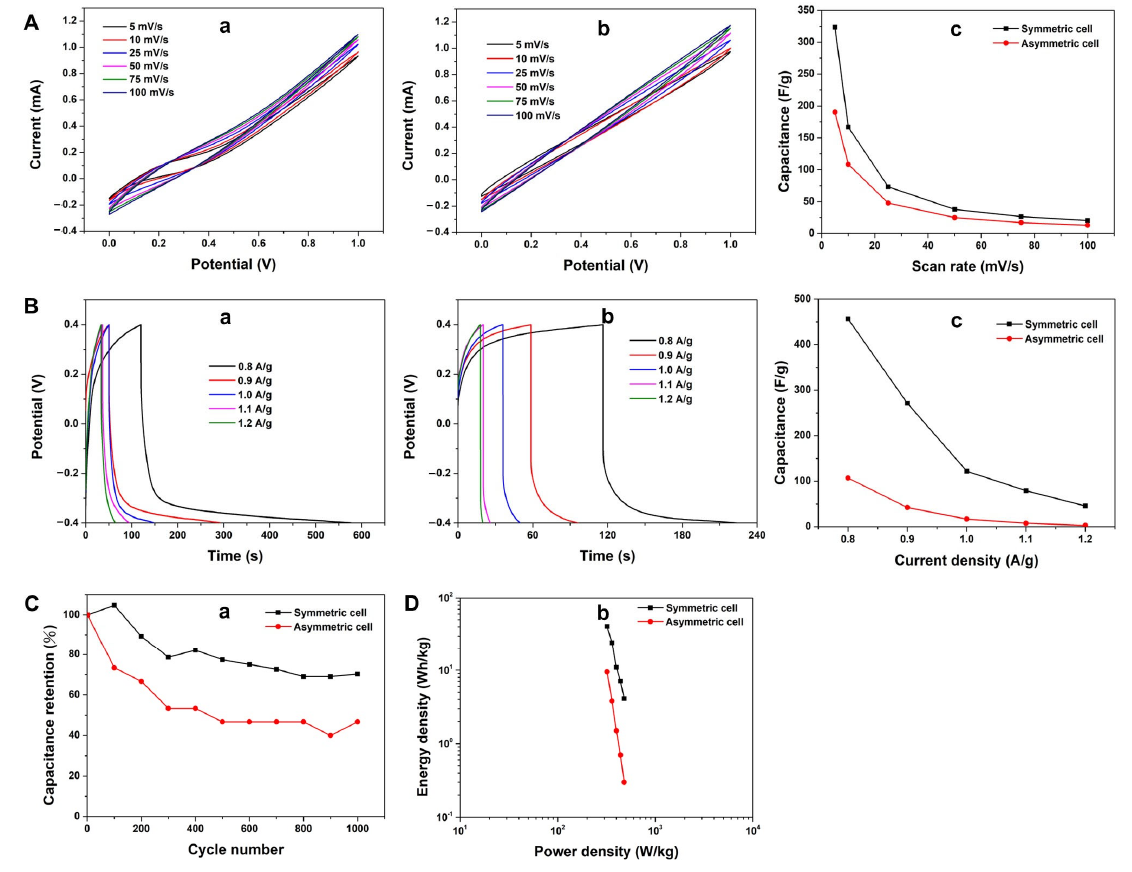
Figure 8. ( A ) CV and ( B ) GCD curves of ( a ) symmetric ( A ) CV and ( B ) GCD curves of ( a ) symmetric (Cdots/PPy/Fe 3 O 4 /TOCNF)// (Cdots/PPy/Fe 3 O 4 /TOCNF)//(Cdots/PPy/Fe 3 O 4 /TOCNF) cell and ( b ) asymmetric (Cdots/PPy/Fe 3 O 4 /TOCNF) cell and ( b ) asymmetric (Cdots/PPy/Fe 3 O 4 /TOCNF)//(Cdots/PPy/ (Cdots/PPy/Fe 3 O 4 /TOCNF)//(Cdots/PPy/TOCNF) cell and ( c ) specific capacitance at various scan TOCNF) cell and ( c ) specific capacitance at various scan rates. ( C ) Cycle stabilities and ( D ) a Ragone rates. ( C ) Cycle stabilities and ( D ) a Ragone diagram of symmetric and asymmetric cells. diagram of symmetric and asymmetric The cycle stability of the symmetric and asymmetric cells for 1000 cycles was evalu ‐ ated at a current density of 1.7 A/g (see Figure 8C). In the case of the symmetric cell, the specific capacitance dropped to about 80% after 200 cycles, but the tendency of the drop weakened in the subsequent cycles. Finally, the capacitance of the cell remained at 70% for 1000 cycles. In the asymmetric cell, the specific capacitance decreased by about 20% at 100 cycles, and the cycle stability after 1000 cycles was only 47%, which was worse than that of the symmetric cell.